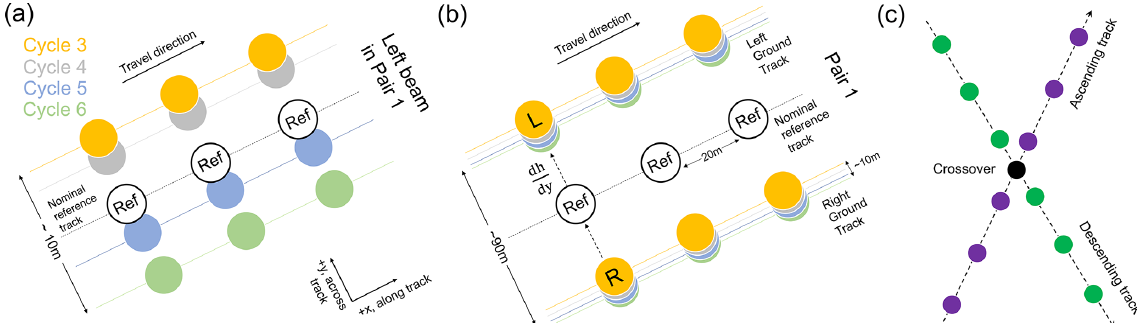
Figure 4. Schematics for repeat-track analysis and crossover analysis. (a) Repeat-track analysis method for left beams in beam pair 1 (out of three beam pairs) from four repeat cycles 3–6. Black circles are the nominal reference track. (b) Repeat-track analysis method for both left and right beams in beam pair 1 from four repeat cycles. Within each repeat cycle, elevations of two beams in a pair were corrected for across-track slope onto the nominal reference track in the middle. (c) Crossover method showing the interpolation along the ascending track (purple dots) and the descending track (green dots) to their intersection as the crossover (black dot).